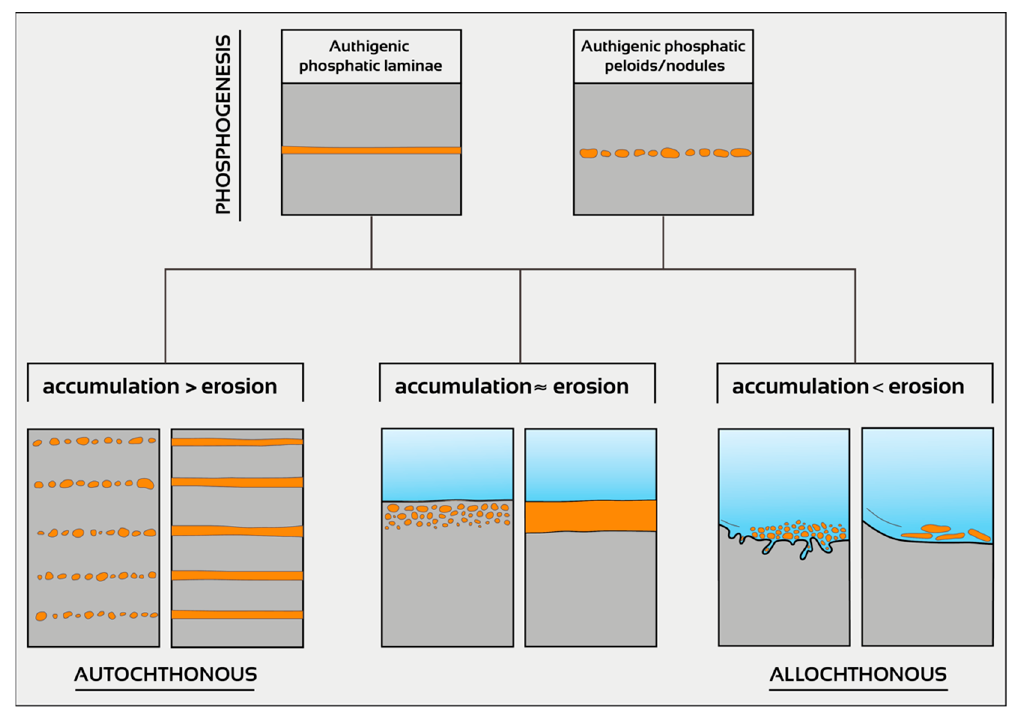
Figure 2. Genetic phosphate classification: pristine vs. reworked phosphate (based on [13]).